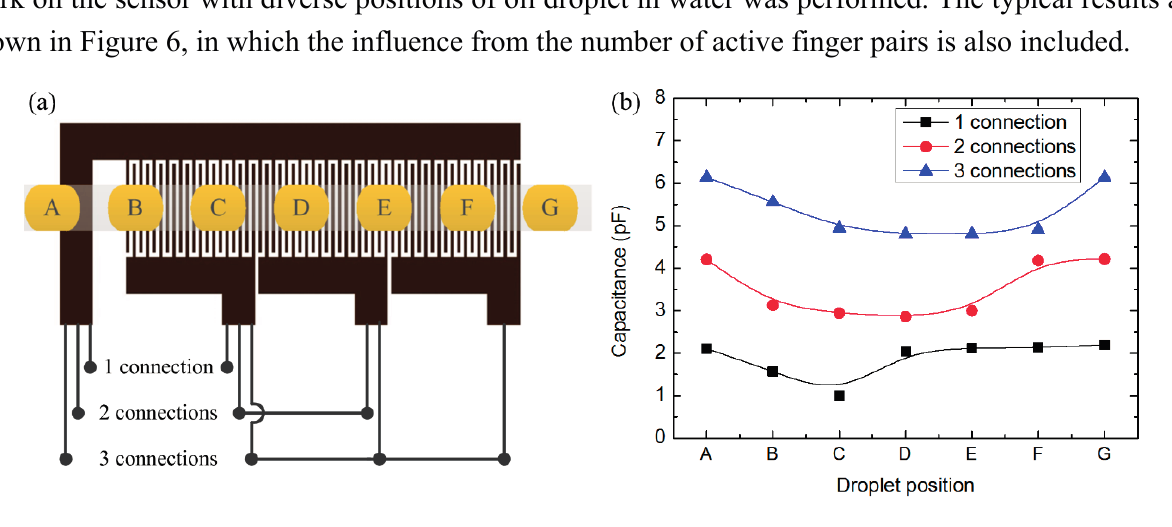
Figure 6. Capacitance variation induced by a 1.6 mm long oil droplets in water: ( a ) droplet positions ( A – G ) relative to the sensor; the active number of finger pairs was changed with 1, 2, and 3 connections; ( b ) capacitances in response to different droplet